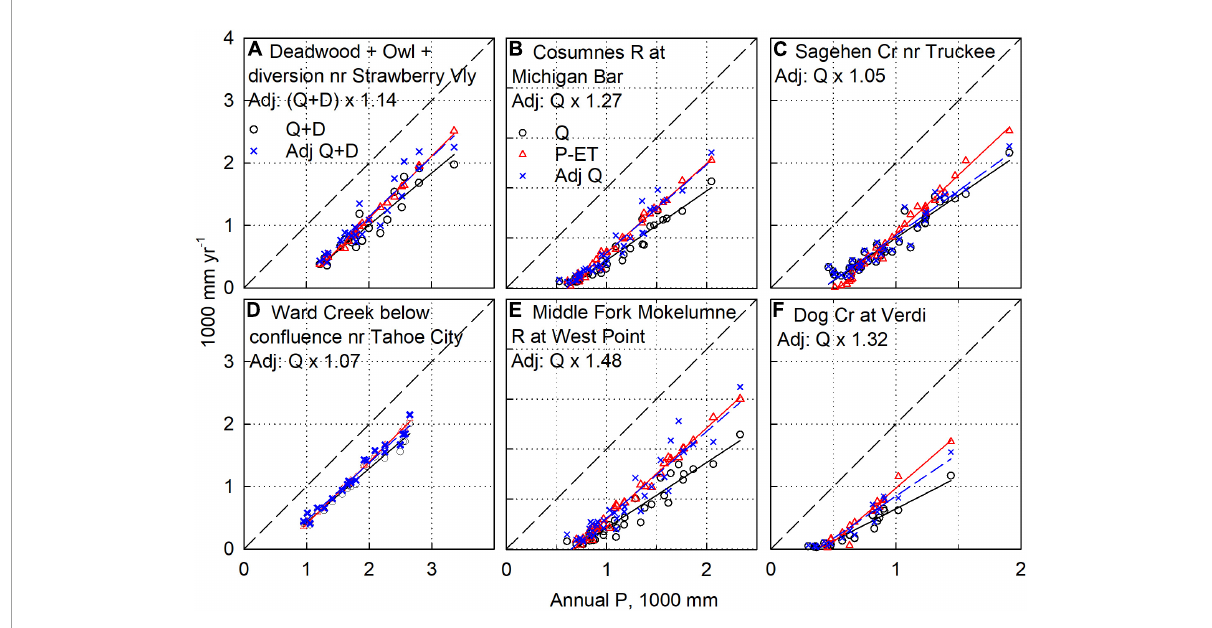
FIGURE5 Water-balance analysis on representative watersheds, with adjustments to Q values. Note that each of the three columns has different scaling, with the dashed diagonal being the 1:1 line. Q values were multiplied by a constant, to improve agreement between P-ET and Q (labeled Adj Q ). Note that (A) is the sum of two measured flows, with reported diversion for the combined flow added ( D ) in. For (A) , the very wet WY 2017 was removed, owing to apparent under-measurement (see text and Figure 4J ). Data for additional sites are in Supplementary Figures S1–S7